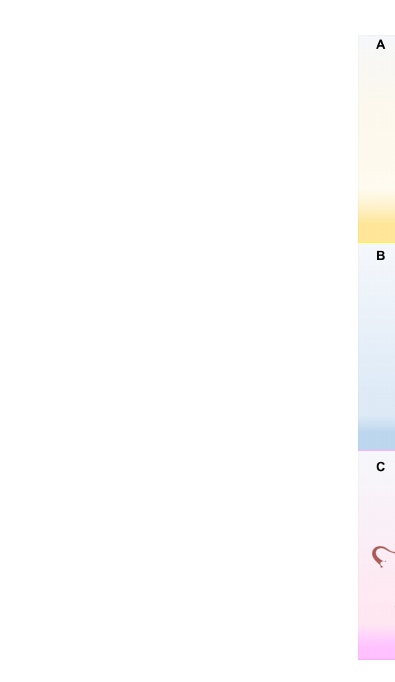
FIGURE 2 | Three-dimensional cell cultures. (A) Scheme representing the cellular spheroids grown in ultra-low attachment plates. In this system, cancer cells are deposited on an ultralow fi xation plate that prevents sticking and allowing the grown of cells in suspension; or alternatively they are placed in spinning fl asks and subjected to gravitational forces also inducing the spheroids formation. (B) Schematic representing organotypic models, where organotypic models have been generated in monoculture or in combination with fi broblasts cocultures. (C) Representative schematic of organoid establishment from pluripotent stem cells (iPSCs) and cancer cells. The iPSCs fi rst undergo reprogramming, followed by directed differentiation, and are then seeded into an extracellular matrix in a speci fi c culture medium to initiate organoid culture. The tumor tissue organoids were processed to remove excess fat and necrotic cells and cut into small pieces. They are then seeded on